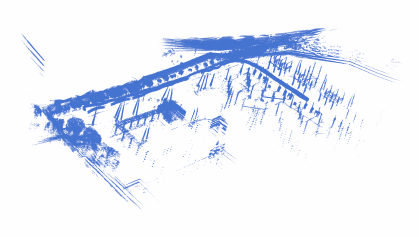
Figure 10. The reconstruction result of the power site without ground plane information.